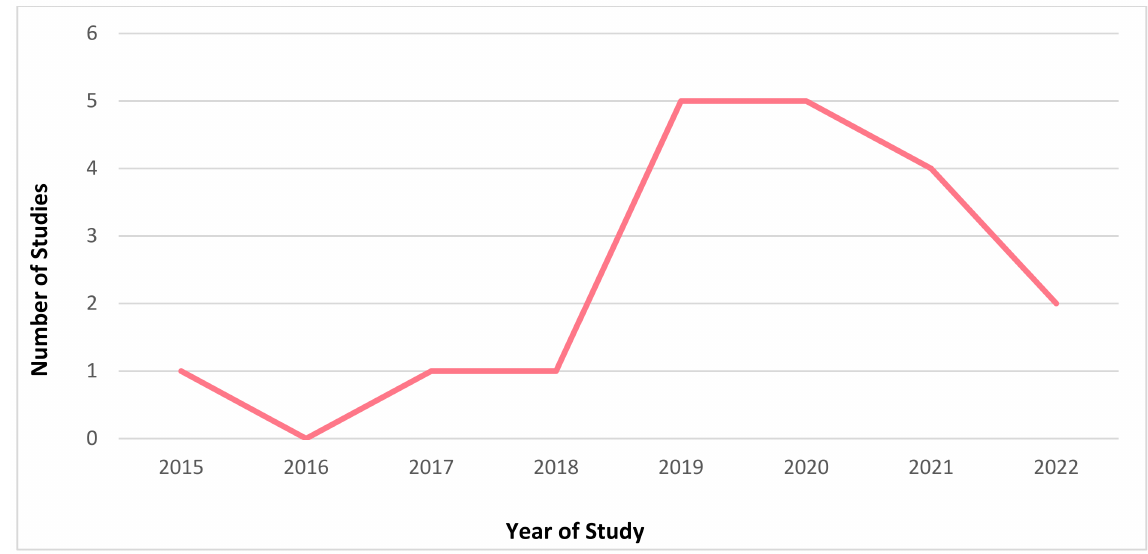
Figure 3. Frequency of published articles in a particular year selected for this review.